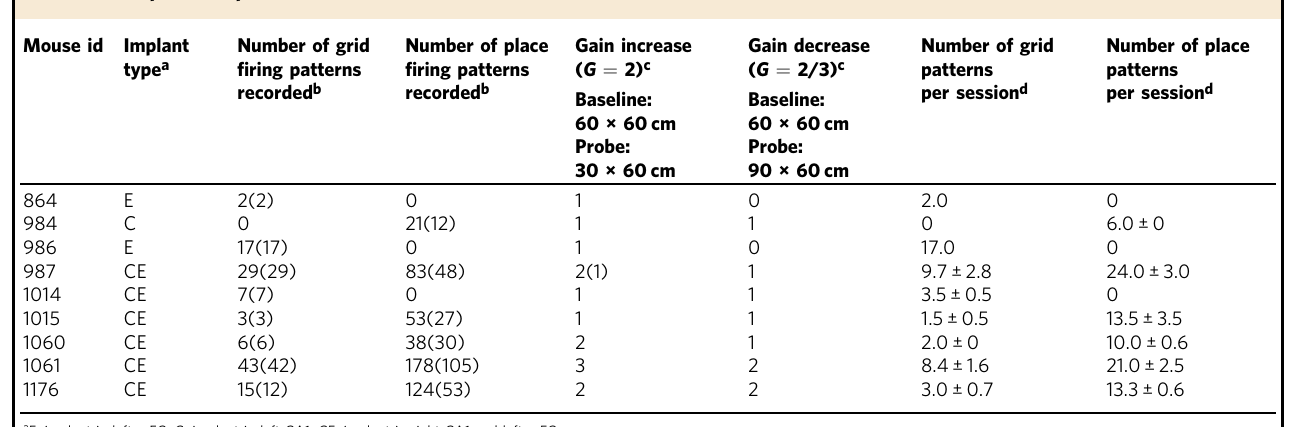
hexagonal fl oor tiles we plotted the scales and phases of grid cell fi ring patterns relative to the fl oor pattern — fi nding no correspondence (see Supplementary Figure 14). Speed-modulated cells were classi fi ed from the population of the recorded cells in baseline trials, following ref. 27 . Brie fl y, the degree of speed modulation for each cell was characterised by fi rst de fi ning the instantaneous fi ring rate of the cell as the number of spikes occurring in each position bin divided by the sampling duration (0.02 s). Then a linear correlation was computed between the running speeds and fi ring rates across all position samples in a trial, and the resulting r -value was taken to characterise the degree of speed modulation for the cell. To be de fi ned as speed- modulated, the r -value for a cell had to exceed the 99th percentile of a distribution of 1000 r -values obtained from spike shuf fl ed data. Cells in mEC were de fi ned as spatial non-grid cells, using similar criteria to place cells, if their spatial information in the baseline trial exceeded the 99th percentile of the shuf fl ed distribution of spatial information and their gridness scores in the baseline trial did not exceed the 99 th percentile of the shuf fl ed gridness score distribution. To identify ‘ remapping ’ as opposed to stretched or offset fi ring rate maps, we calculated the spatial correlation between a baseline fi ring rate map and the best- matching (stretched and offset) probe rate map (described above). We de fi ned a remapped cell as having a spatial correlation between the two maps below 0.3. Only non-remapped place cells and grid cells were included in further analysis, leaving 425 out of 497 place cells and 118 out of 122 grid cells that were quanti fi ed as non- remapping cells. The proportions of place cells remapping between baseline and probe conditions did not differ between gain increase and gain decrease sessions (Supplementary Figure 5). For place cells, we then identi fi ed fi ring fi elds at 30% peak fi ring rates, and considered those cells whose fi elds covered more than 50% of either probe or baseline environments as too diffuse for analyses, leaving 275 out of 497 compact non-remapping place cells for further analysis. To compare grid scale changes along different axes, we fi tted an ellipse circumscribing the six peaks nearest to the centre on the autocorrelogram of a cell. The grid was not included in the analysis if the number of nearest peaks was less than six. We then measured the diameters of the ellipse along manipulated and un- manipulated axes. The ratios of the diameters in probe trials to those in baseline trials were calculated based on the autocorrelograms generated in visual coordinates and motor coordinates. To determine the ‘ motor in fl uence score ’ for fi ring patterns, a set of 20 transformed probe trial fi ring rate maps were generated via linearly interpolating fi ring rate maps plotted in a visual coordinate by stretch factors ranging from 1 to the applied gain ratio in 20 steps. Correlations between the transformed probe maps and baseline rate maps were then calculated with offsets of 1.5cm intervals along the manipulated axis between the smaller to the larger map, keeping the largest 12 . A stretch factor ( F ) was de fi ned as the factor that produced the largest spatial correlation. The visual gain G is the ratio distance moved by the viewpoint in VR divided by the distance moved by the mouse on the ball surface. The ‘ motor